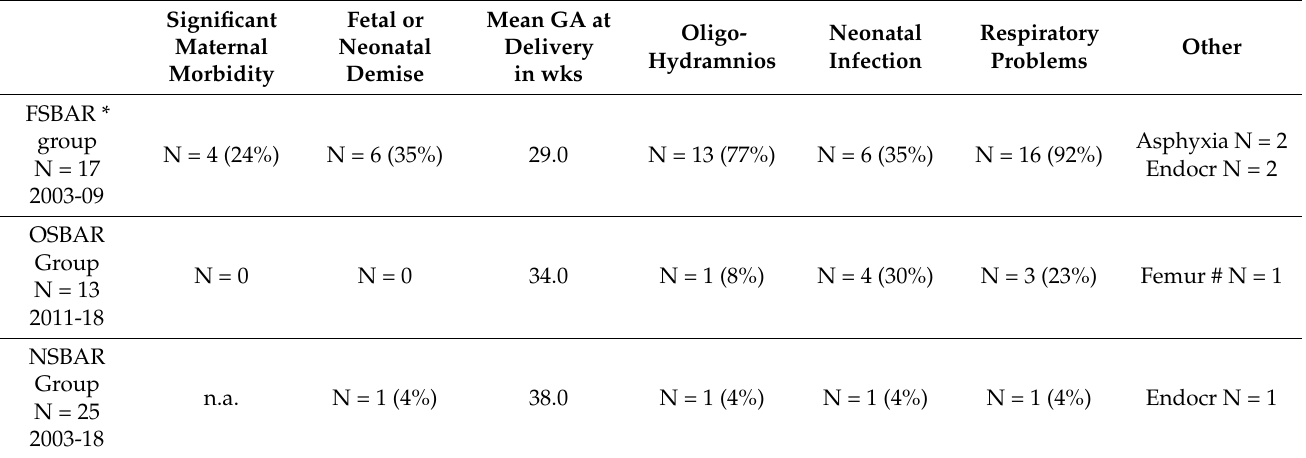
Table 3. Clinical